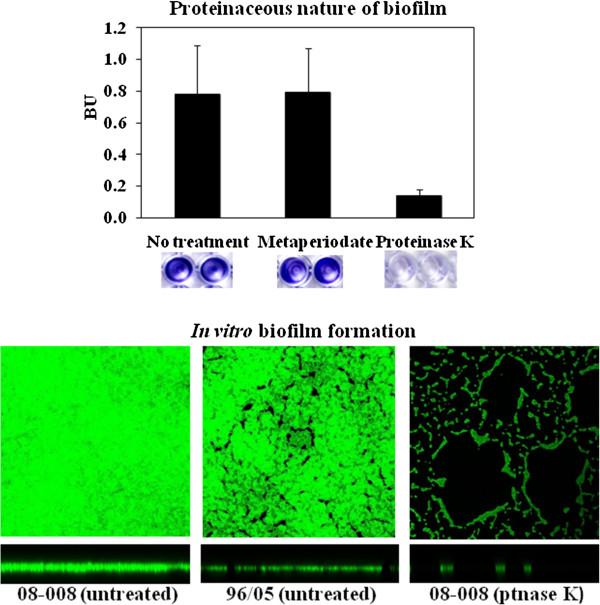
Proteinaceous nature of the biofilm. Top: Effect of 1mM/well sodium metaperiodate or 6U/well proteinase K on preformed biofilm. Wells show the effect of these compounds on biofilms preformed on inert polystyrene surfaces by representative ST1 isolates. Bottom: Confocal laser scanning microscopy (CLSM) images of proteinase K-treated and -untreated biofilms stained with SYTO 9. The square indicates the slice of the biofilm from which the XY image was taken. The horizontal bar indicates the location of the X plane from which the cross-section was taken. Isolate 08–008 (strong biofilm producer, agr-dysfunctional), 96/05 (moderate biofilm producer, agr-functional).